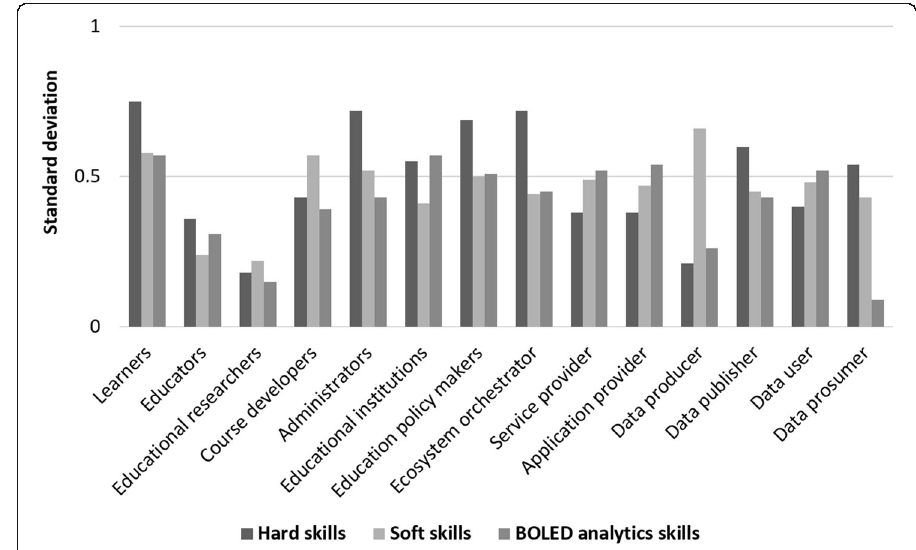
Fig. 9 The mean standard deviation values for each category of skills provided by the Delphi-based expert opinion poll